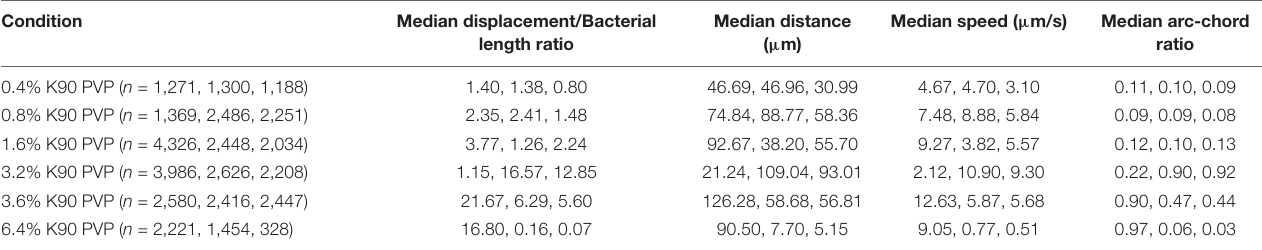
Values correspond to Figure 1 and Supplementary Figures 1 , 3 (first, second, and third given value, respectively). For a full set, including average, 25 and 75 percentiles for each property, as well as distance, displacement, and bacterial length see Supplementary Table 1